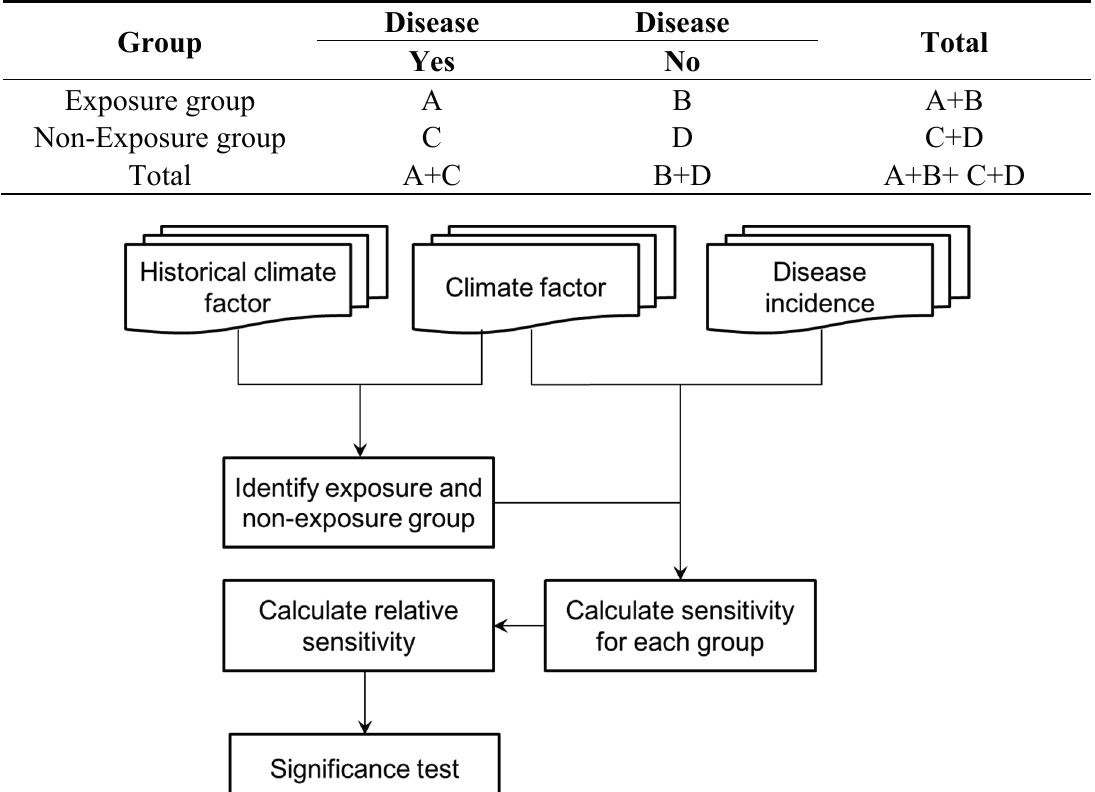
Table 1. A 2×2 table for epidemiological relative risk calculation.